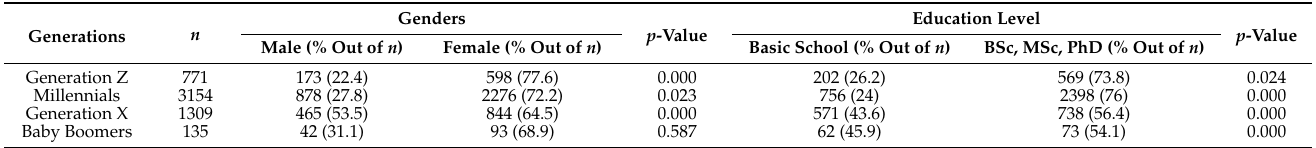
Table 1. Genders and education level amongst generations, n =